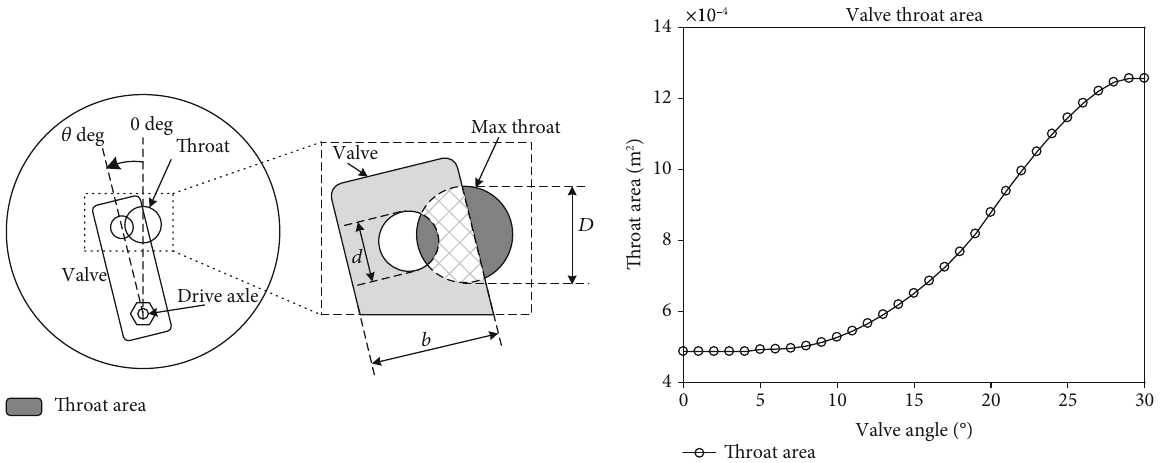
Figure 3: The platform of the gas generator and schematic of the throat area.